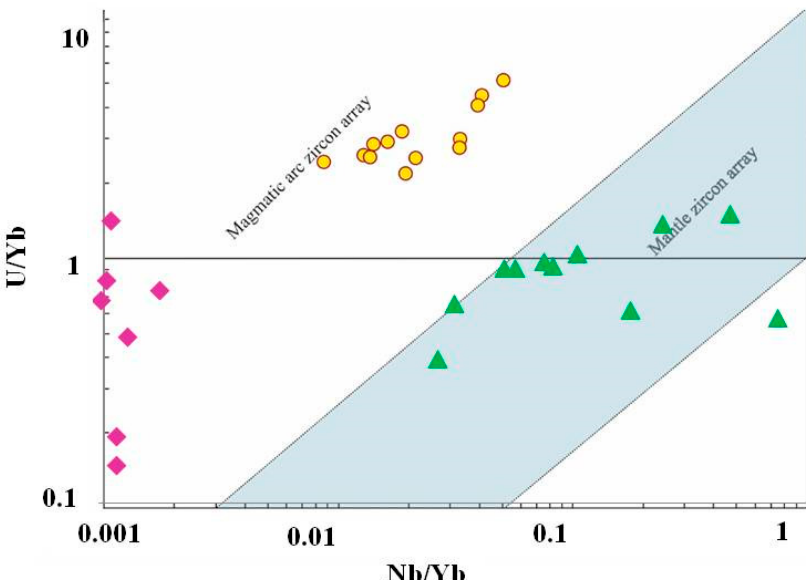
Figure 17. U / Nb vs. Nb / Yb discriminant diagram of zircons from kyshtimtes (bold yellow circles), miascites (bold purple diamonds), and carbonatites (bold green triangles) of the Ilmenogorsky- Vishnevogorsky complex (the chemistry on miascites and carbonatites is modified after [45]); fields for mantle and magmatic arc arrays are from Grimes et al. (2015) [58].